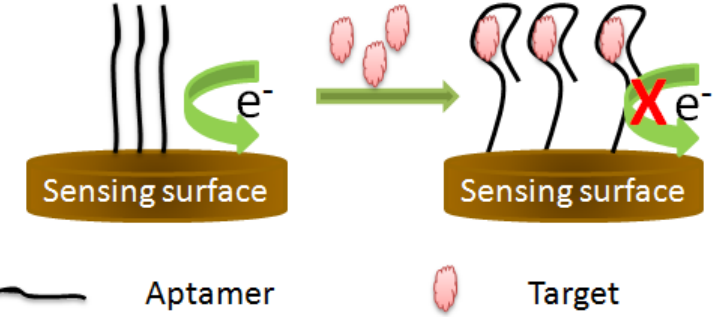
Figure 4. Principle of target-induced variation in charge transfer resistance.